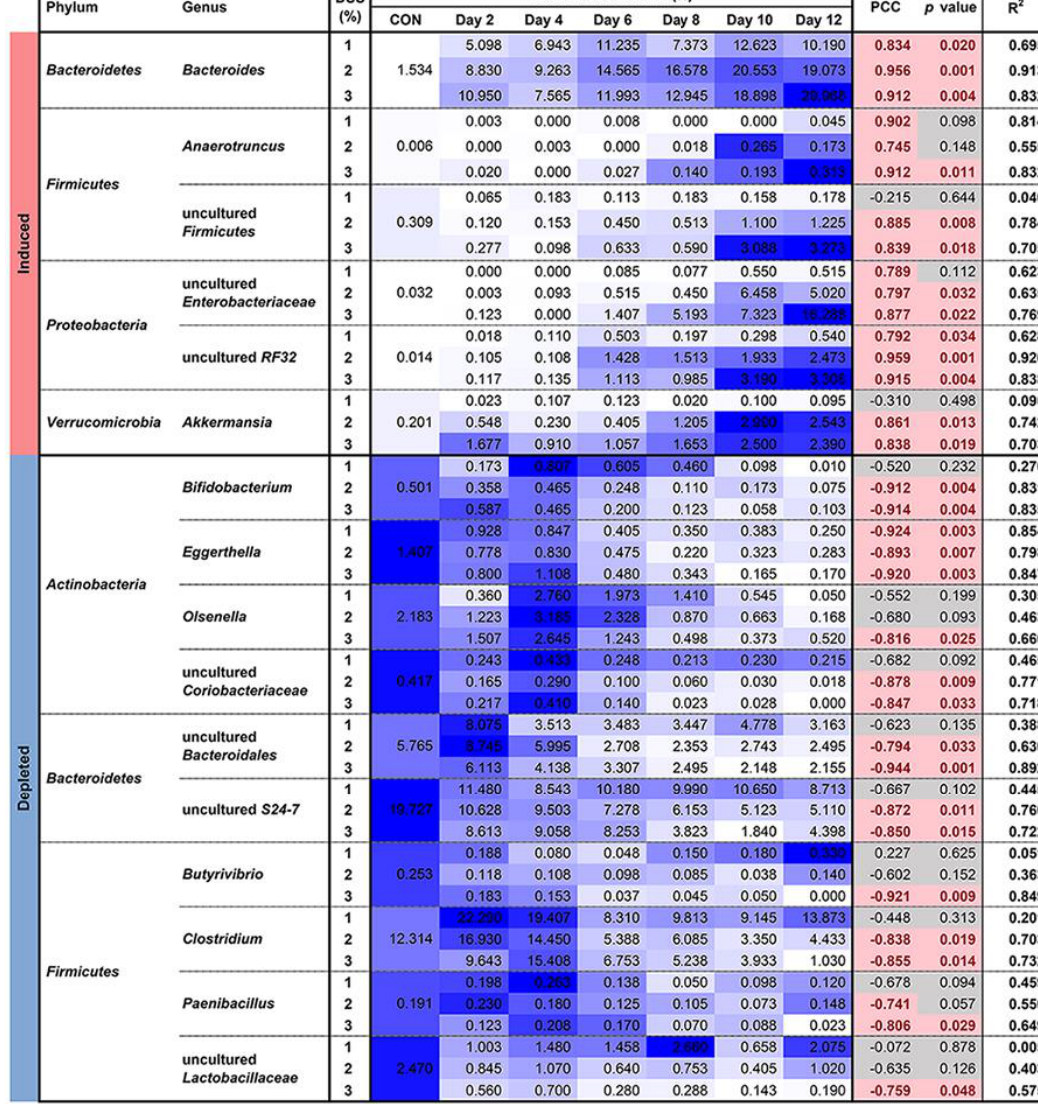
Figure 3. Changing genera depending on DSS exposure. Pearson correlation between the resulting relative abundances (RAs) and DSS duration are indicated. Red represents PCC > 0.7 or < −0.7 with p value < 0.05. Blue gradients represent the intensity of RAs within each genus.